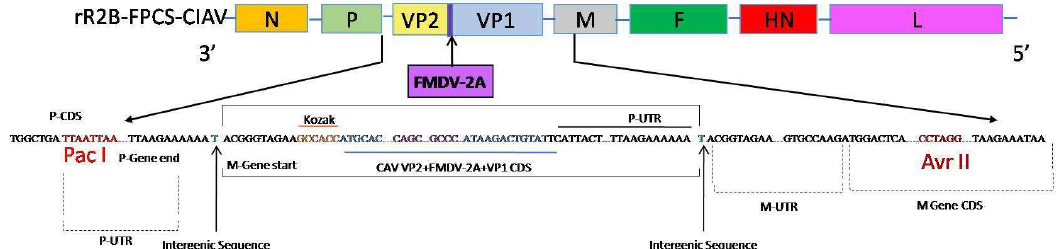
Figure 2. The NDV-R2B-FPCS backbone generated by reverse genetics contained the altered FPCS amino acid motif similar to that of a lentogenic strain of NDV. The VP2/VP1 gene cassette of CIAV was introduced between the P and M genes bound by restriction enzymes Pac I and Avr II. A 60 nucleotides FMDV 2A protease sequence was introduced between the VP2 and VP1 of CIAV. P CDS: P gene coding sequence; P-UTR: P gene non-coding region; M-UTR: M gene non-coding region; M Gene CDS: M gene coding sequence.